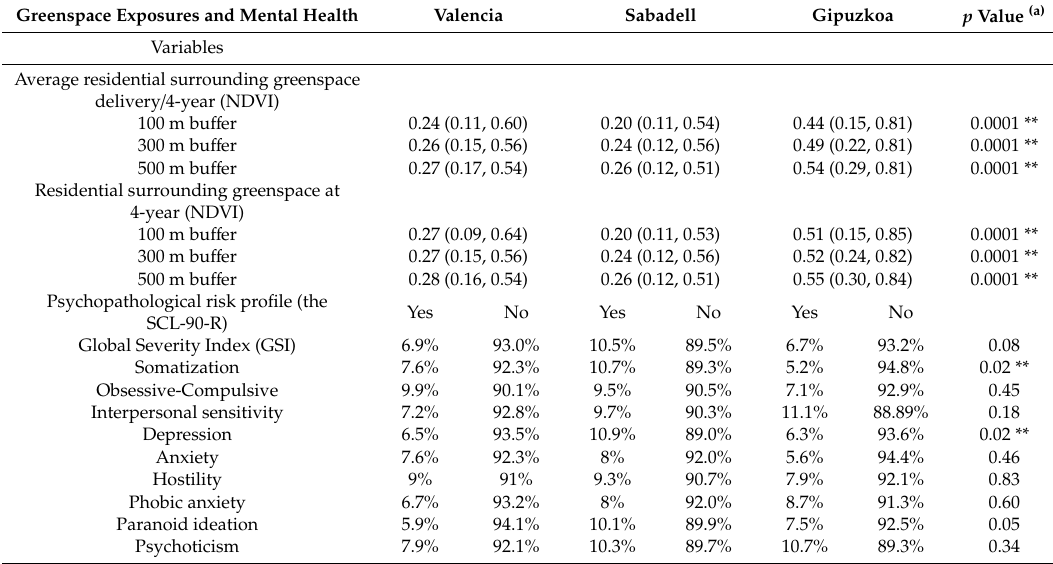
Description of the average residential surrounding greenspace at delivery and the 4-year follow-up (NDVI), residential surrounding greenspace at the 4-year follow-up (NDVI), and psychopathological risk profile (SCL-90-R) separately by study